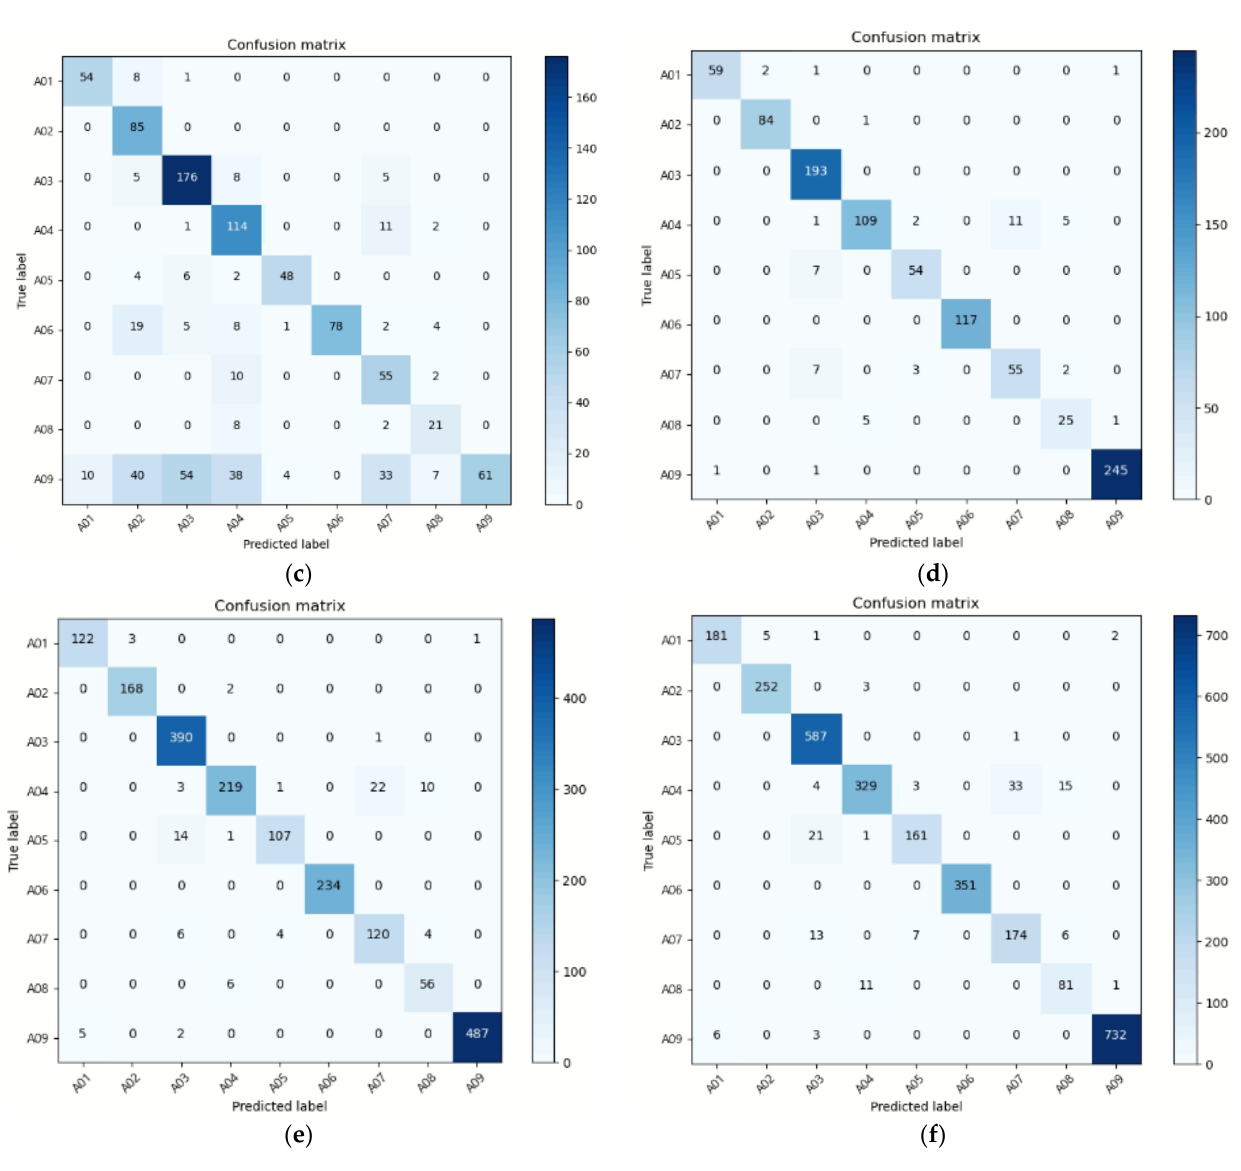
Figure 9. Confusion matrix of activity classification: ( a ) 1 channel sensor data distortion (0.5% noise), ( b ) 3 channels sensor data distortion (16.7% noise), ( c ) 6 channels sensor data distortion (33.3% noise) ( d ) image data distortion (normal and left-right reverse data), ( e ) image data distortion (normal and top-bottom reverse data), ( f ) image data distortion (normal and left-right reverse and top-bottom reverse data).